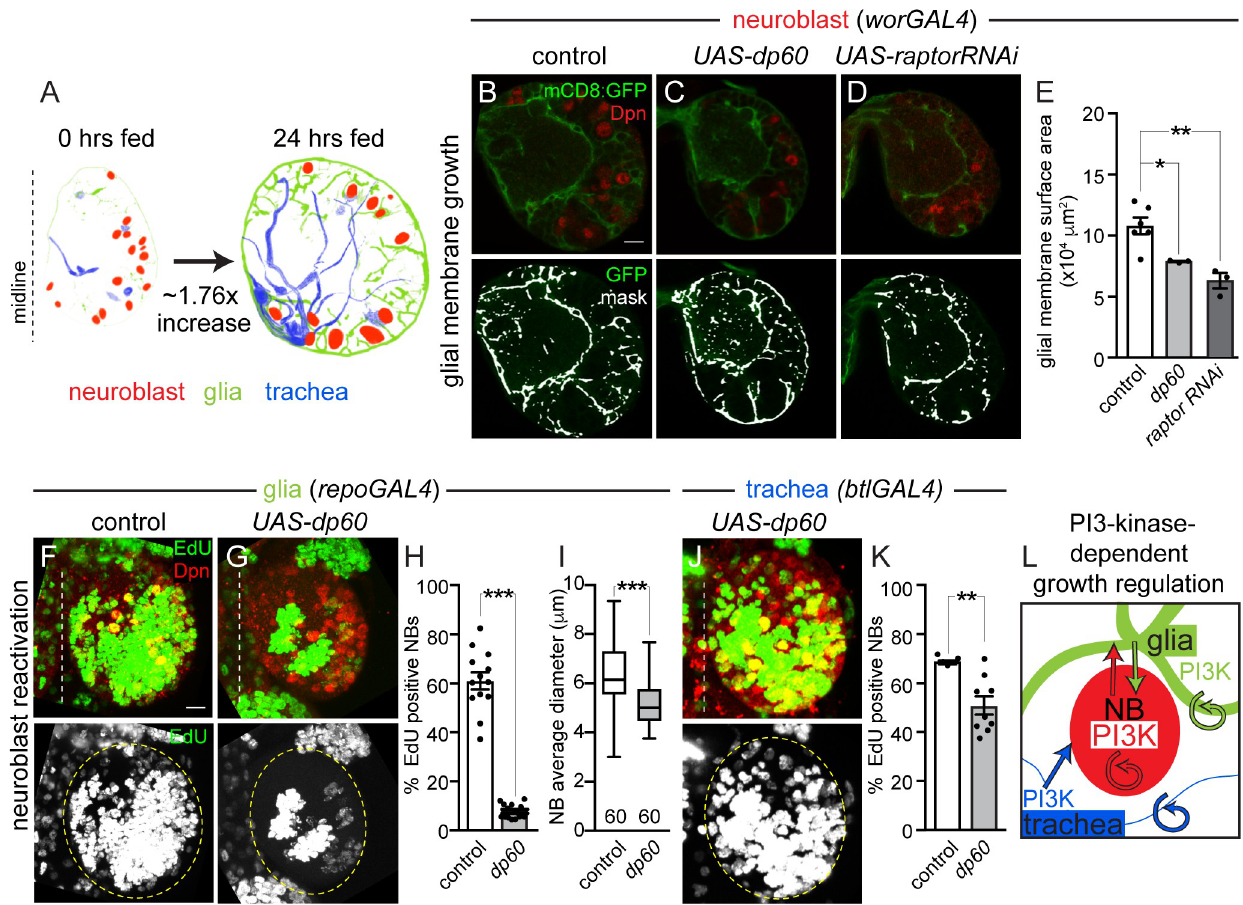
Fig 2. Nutrient-dependent growth of NBs, glia, and trachea requires cell-autonomous and non-cell–autonomous PI3-kinase activation. (A) Images of segmented brain hemispheres with cell types colored as indicated. (B–D) Single Z images of brain hemispheres. Top panels are colored overlays, and bottom panel are single-channel images overlaid with the mask used for quantification (E) (see Materials and Methods). (F,G,J) EdU-positive NBs after 24 hours of feeding. Maximum intensity projections of brain hemispheres from the indicated genotypes. Top panels are colored overlays, and single-channel grayscale images are below. Brain hemispheres are outlined, and the dotted vertical line to the left indicates the midline. Quantification of EdU-positive NBs (H,K) and NB size (I). (L) Summary of PI3-kinase growth regulation between different cell types in the brain. Circular arrows indicate requirement for autonomous PI3-kinase growth signaling, and straight arrows indicate nonautonomous growth signaling. (E) One-way ANOVA with Tukey post hoc analysis. (H,I,K) Student two-tailed t test, � p < 0.05, �� p < 0.01, ��� p < 0.001, error bars, SEM. Genotypes of panels listed in S2 Table and data listed in S1 Data. btl , breathless ; Dpn, Deadpan; dp60 , Drosophila protein 60 ; EdU, 5-ethynyl-2 0 -deoxyuridine; GFP, green fluorescent protein; mCD8, membrane- targeted CD8 antigen; NB, neuroblast; PI3-kinase, phosphoinositide 3-kinase; raptorRNAi , raptor RNA interference; repo , reversed polarity ; UAS , upstream activating sequence; wor , worniu